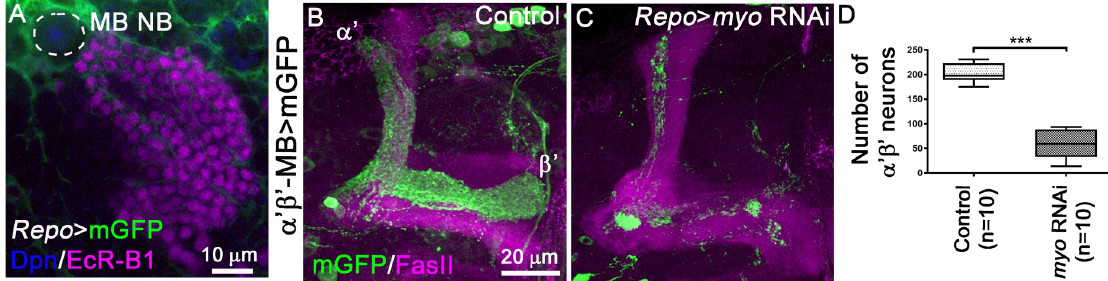
Fig 5. Reduced levels of Myoglianin in the glia lead to reduction of α ’ β ’ MB neuron number. (A) MB neuroblast (Nb) stained with anti- Dpn antibody (blue), MB neurons stained with anti-EcR-B1 antibody (magenta) used as landmark in locating MB neuroblast and glia labelled with GAL4-Repo -driven mGFP (green). (B,C) Adult MB lobes from control (B) and Repo > myo RNAi (C) brains stained with anti- FasII antibody (magenta). Green: GMR26E01 - LexA- α ’ β ’ - MB-driven mGFP in B,C. (D) Quantification of number of adult α ’ β ’ MB neuron cell bodies from control and Repo > myo RNAi brains. Statistical comparison to the control: ��� , p < 0.001 (two tailed t